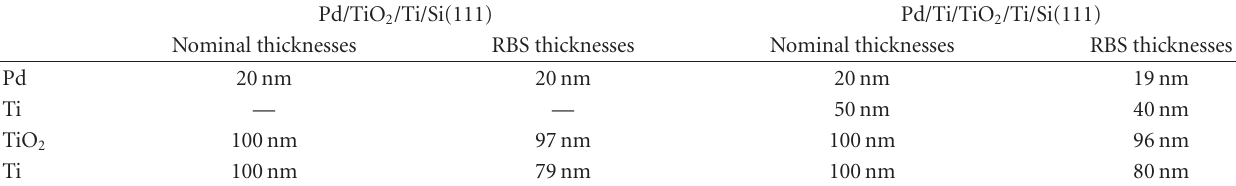
Table 1: Thicknesses of the samples, nominal and obtained from RBS